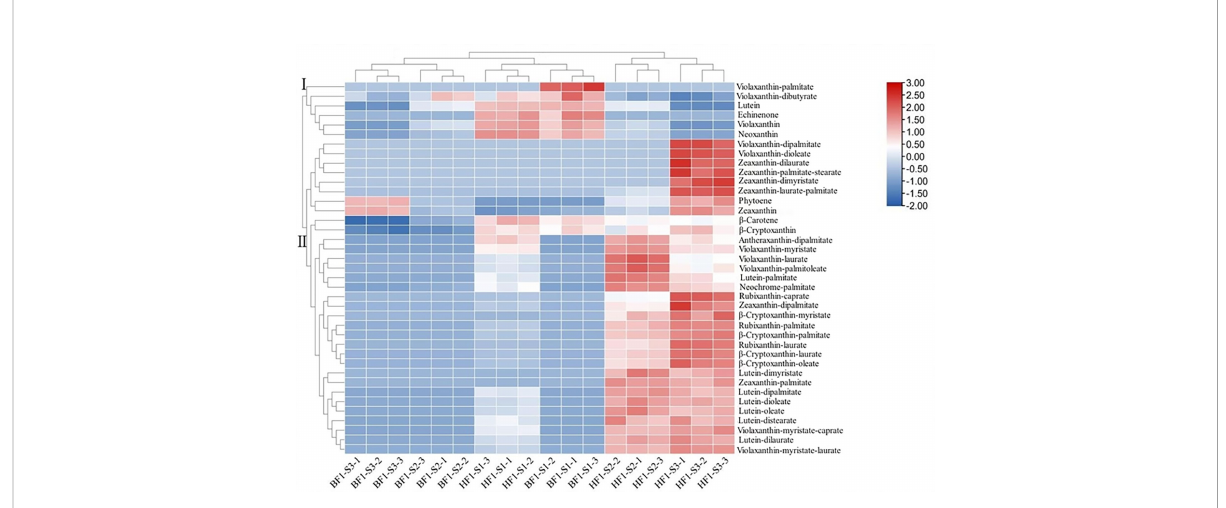
FIGURE 4 Clustering heat map analysis of carotenoid metabolites in hybrid F1 generation peach